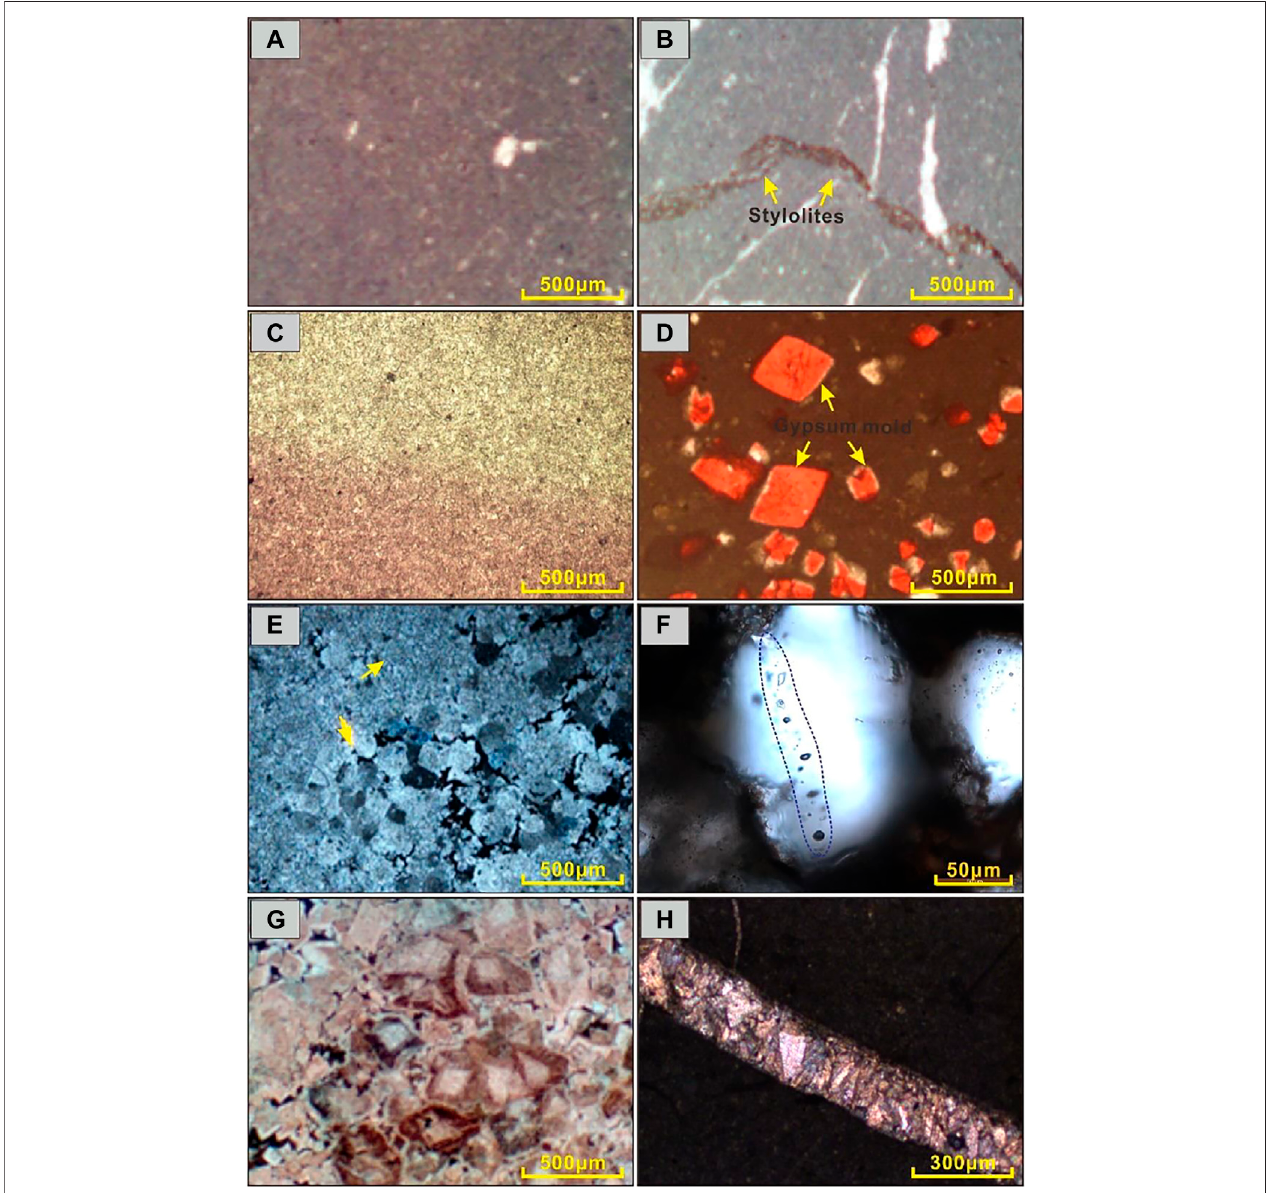
FIGURE2| Photomicrographsshowingthemineralogyofthestudiedsamplesundercross-polarizedlight. (A) Micriticcalcitesshowingvery fi ne-sizedcrystals. (B) Stylolitesdevelopinginthematrixcalcite. (C) Micriticdolomitesshowinginvisiblecrystalsizes. (D) Gypsummoldoccurringinthemicriticdolomite. (E) Sucrosicdolomites exhibitingmedium-sizedcrystal accumulation. (F) Linear distributionof fl uid-inclusion in sucrosicdolomite. (G) Saddle dolomitesdisplaying large crystal size. (H) Saddle dolomites occurring in the fractures.